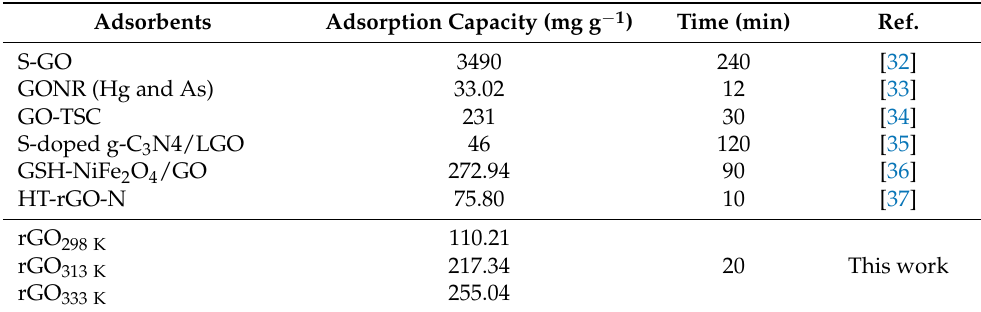
Table 5. Comparative adsorption capacity and adsorption time for the removal of Hg(II) ions using oxidized